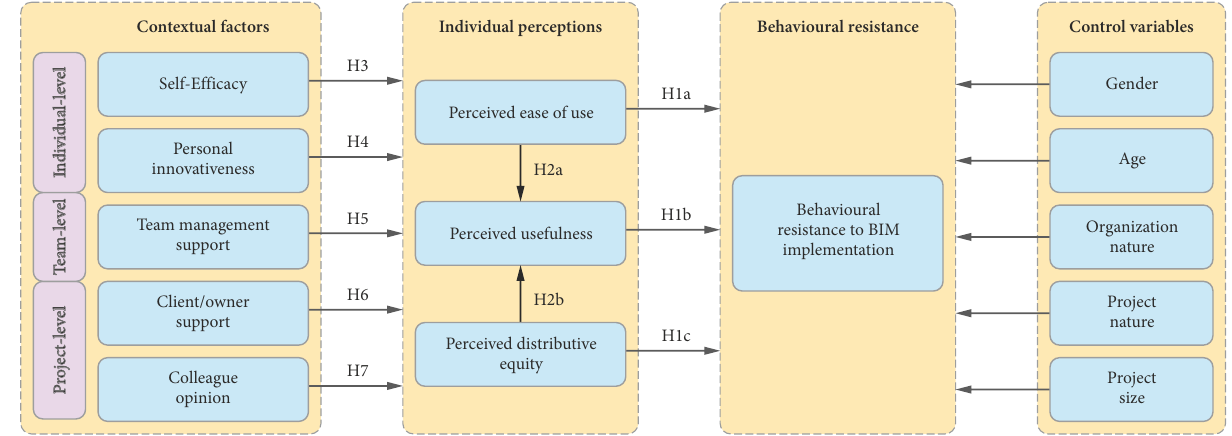
Figure 1. Research